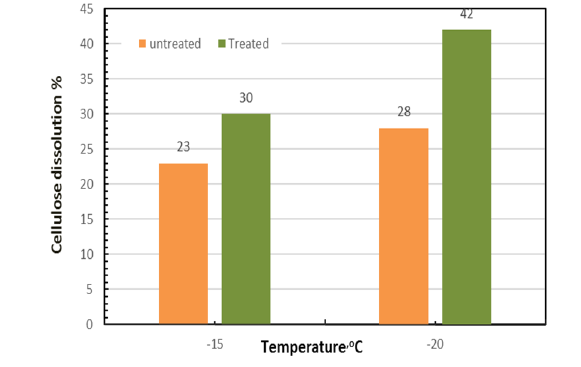
Fig. 10. Effect of urea addition on cellulose dissolution at temperature -20 ±2 o C.